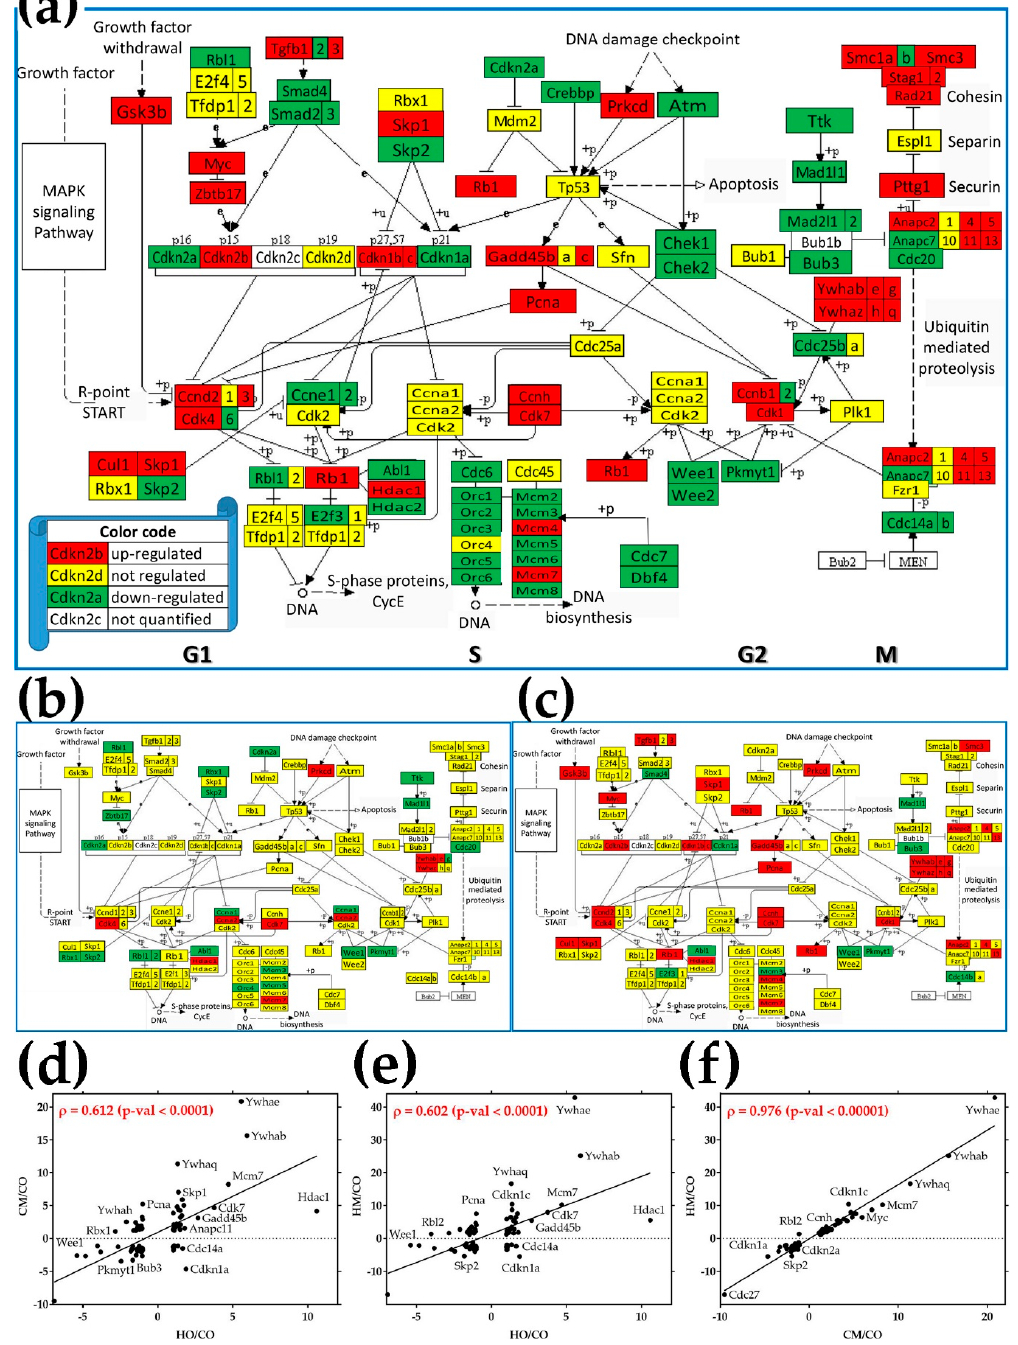
Figure 4. Regulation of the cell-cycle (CC) pathway. ( a ) Rats treated with MCT and exposed to hypoxia (HM); ( b ) rats exposed to only hypoxia (HO); ( c ) rats treated with monocrotaline only (CM). Regulated genes: Abl1 (C-abl oncogene 1, non-receptor tyrosine kinase), subunits of the anaphase promoting complex ( Anapc2, Anapc4, Anapc5, Anapc7, Anapc11, Anapc13 ), Atm (ataxia telangiectasia mutated homolog), Bub3 (budding uninhibited by benzimidazoles 3 homolog), cyclins ( Ccnb1, Ccnb2, Ccnd2, Ccnd3, Ccne1, Ccne2, Ccnh ), cell division cycles ( Cdc14a, Cdc14b, Cdc20 , Cdc25a, Cdc25b, Cdc6 ), cyclin-dependent kinases ( Cdk1, Cdk4, Cdk6, Cdk7 ), cyclin-dependent kinase inhibitors ( Cdkn1a, Cdkn1b, Cdkn1c, Cdkn2a, Cdkn2b ), checkpoint kinases ( Chek1, Chek2 ), Cul1 (culin 1), Dbf4 (DBF4